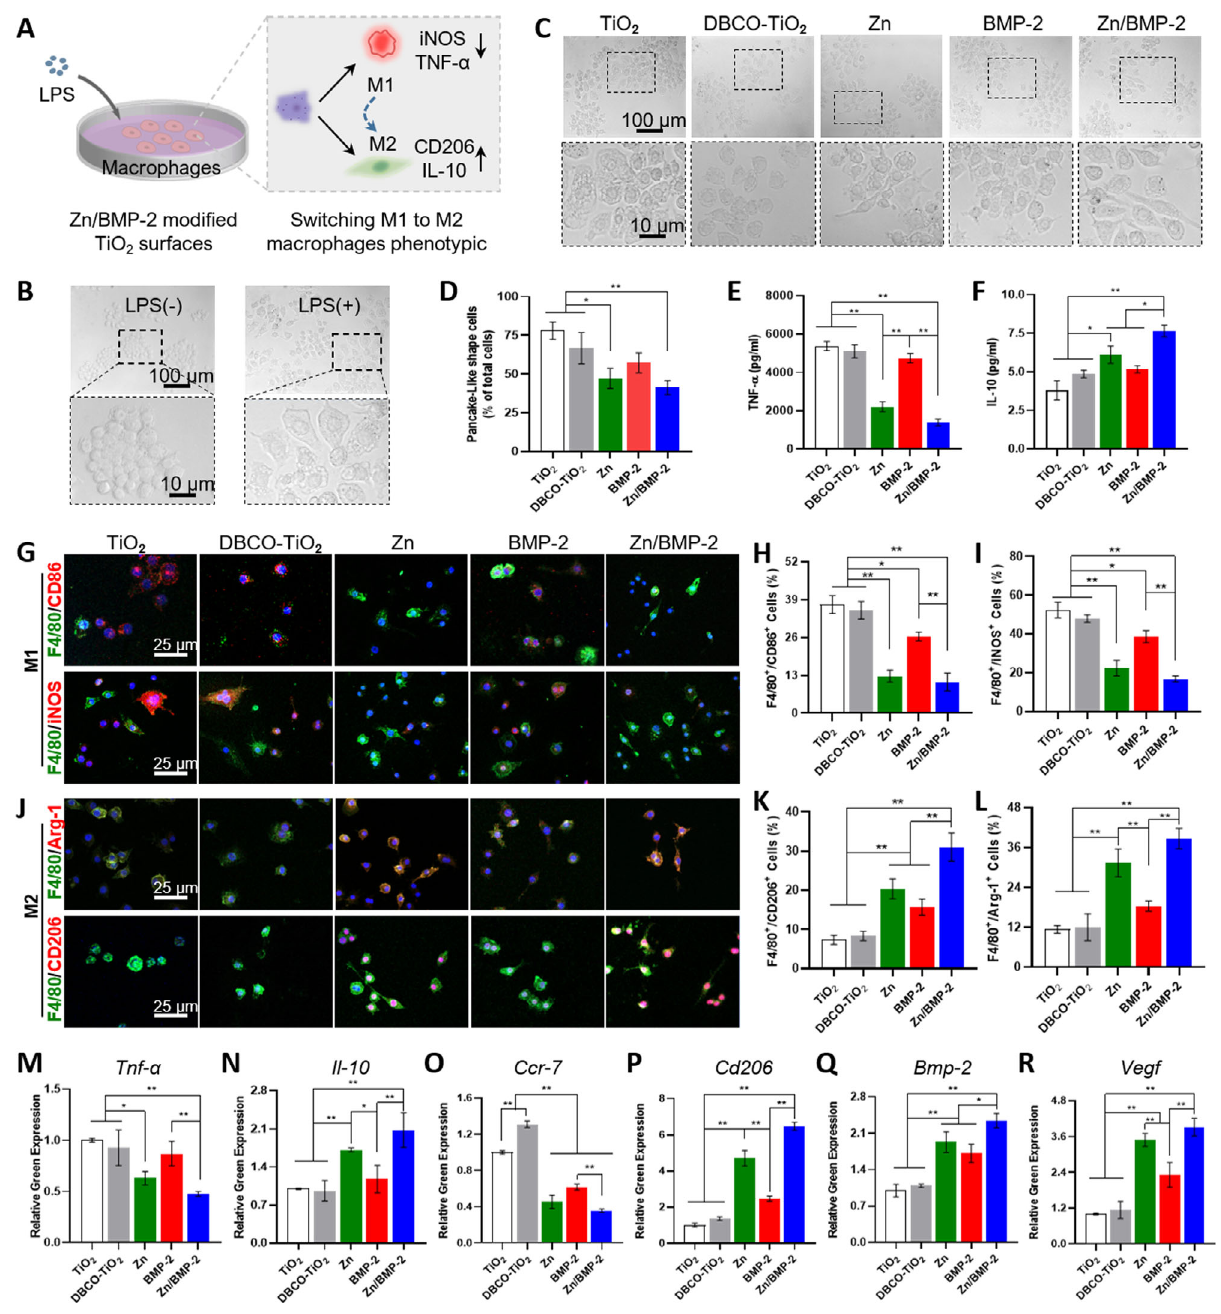
Fig. 4 Zn 2 + and BMP-2 peptide co-modi fi ed TiO 2 surface regulate macrophages polarization in vitro. A The illustration of experimental design; B The morphology of RAW246.7 was stimulated by LPS or without LPS; C The morphology of RAW264.7 was cultured on different surfaces (TiO 2 , DBCO-TiO 2 , Zn, BMP-2, and Zn/BMP-2 surface) (scar bar = 100 μ m and 10 μ m, three independent experiments) and ( D ) Quantitative results of pancake-like shape cells (M1) as a proportion of total cells ( D n = 3 biologically independent samples per group, by a one-way ANOVA with a Tukey ’ s post hoc test for multiple comparisons); E TNF- α and ( F ) IL-10 cytokine secretion by ELISA ( E – F n = 3 biologically independent samples per group, by a one-way ANOVA with a Tukey ’ s post hoc test for multiple comparisons). G , J Immuno fl uorescent staining results for RAW264.7 cultured on different surfaces: red (M1 marker: CD86 or iNOS and M2 marker: CD206 or Arg-1), green (F4/80, a monoclonal antibody speci fi cally directing against the mouse macrophage), and blue (nuclei) (scar bar = 25 μ m, three independent experiments); Corresponding percentage of double-positive macrophages M1 ( H , I ) and M2 ( K , L ) ( H – I , K – L n = 3 biologically independent samples per group, by a one-way ANOVA with a Tukey ’ s post hoc test for multiple comparisons); M – R RT-PCR results of Tnf- α , Il-10, Ccr7, Cd206, Bmp-2, and Vegf respectively ( M – R n = 3, biologically independent samples per group, by a one-way ANOVA with a Tukey ’ s post hoc test for multiple comparisons). Data are reported as mean ± SD, * p < 0.05, ** p < 0.01. Exact P values were given in the Source Data fi